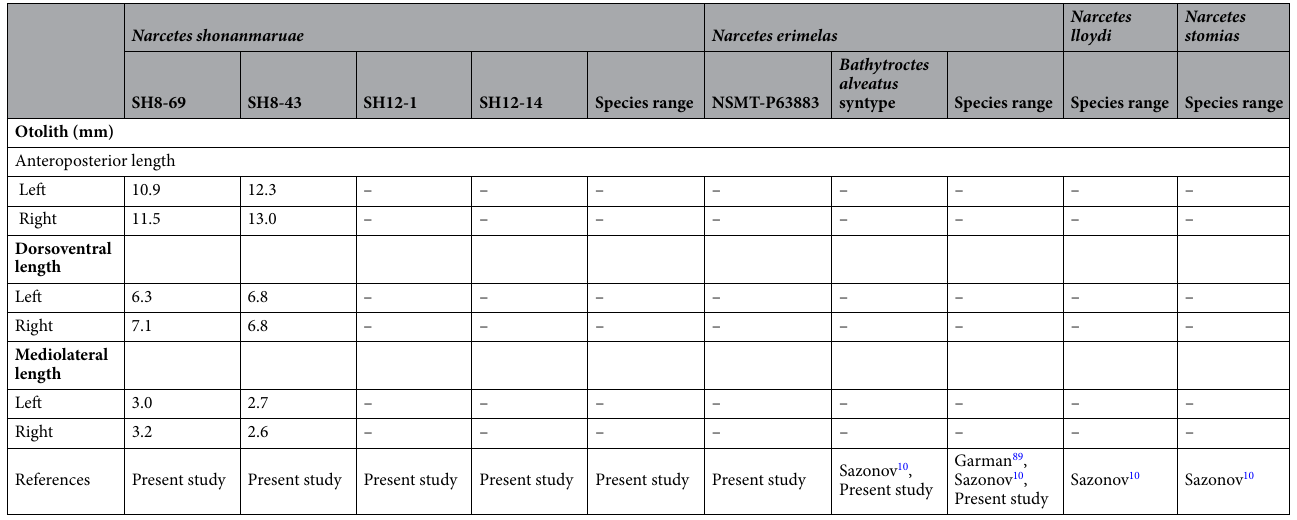
Table 2. Morphometric and meristic information on Narcetes shonanmaruae and relatives . –: Data not shown due to lack of measurements. a Right gill rakers counted due to malformation of left rakers. b Right scale rows counted due to sample condition. c Counted from syntype ID: MCZ